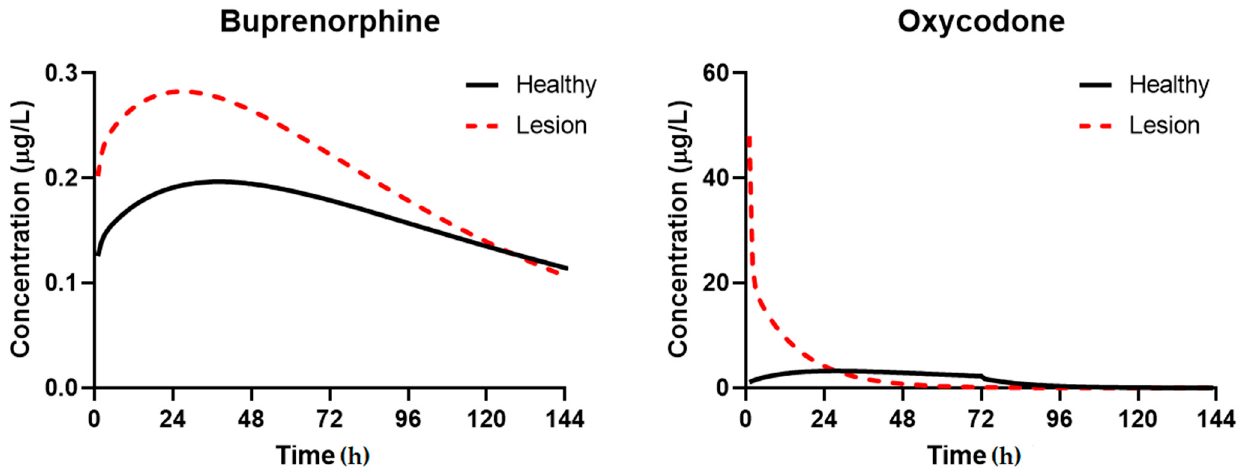
Figure 4. Prediction of the systemic disposition of Buprenorphine and Oxycodone in patients with healthy and compromised skin (lesions). Dosing regimens used for simulation were the same as cited in Table 4.